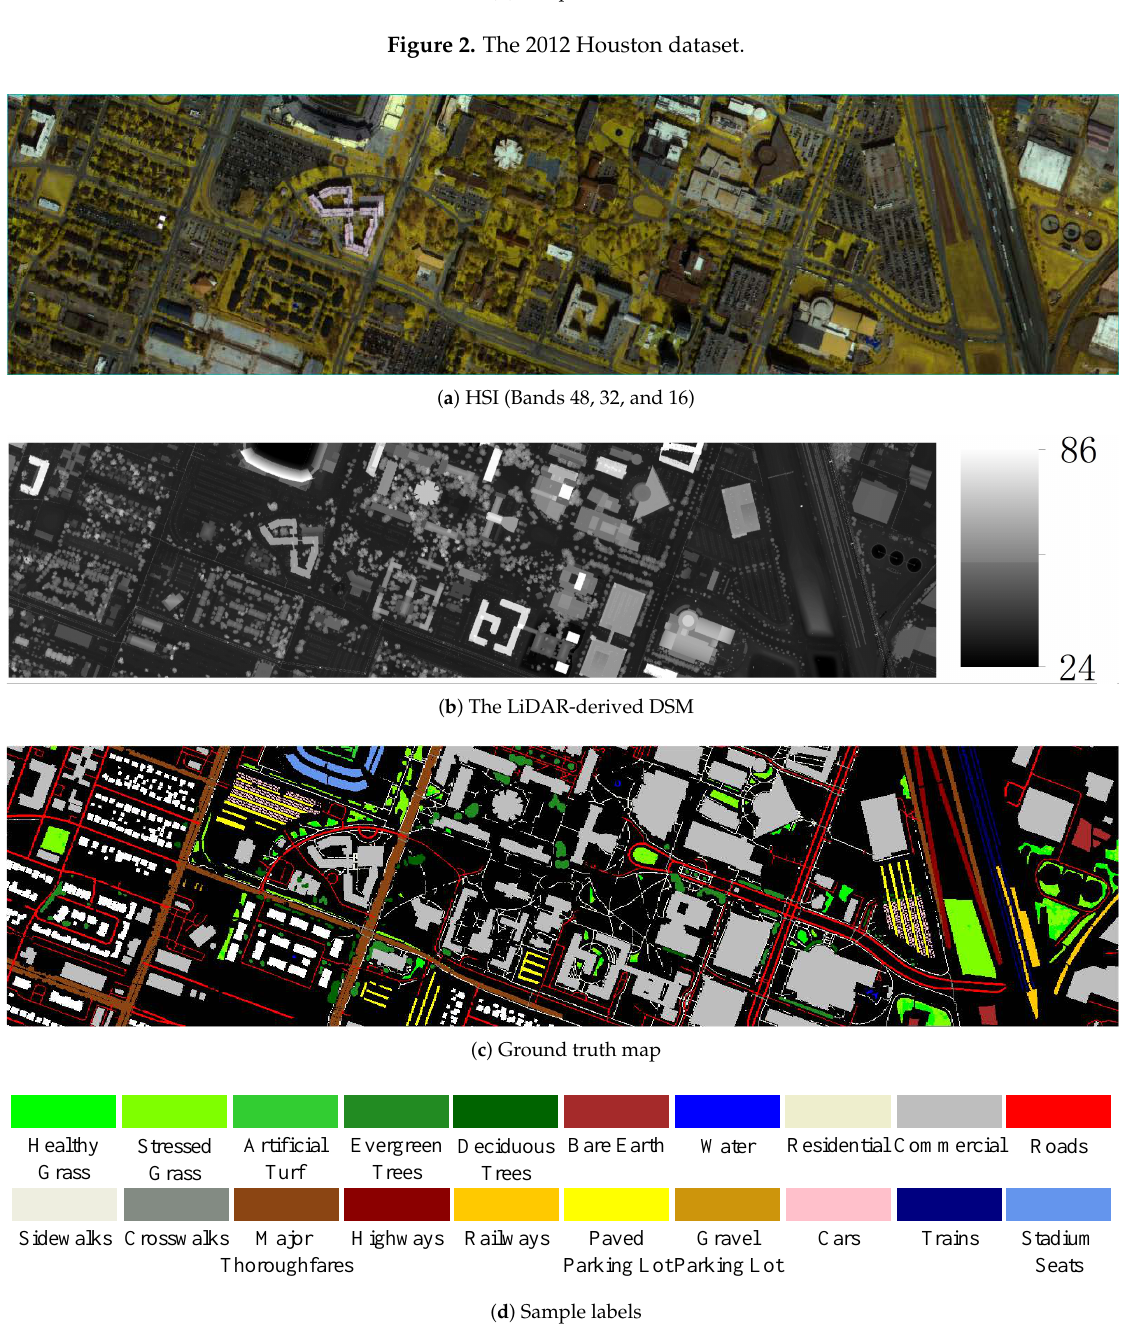
Figure 3. The 2017 Houston